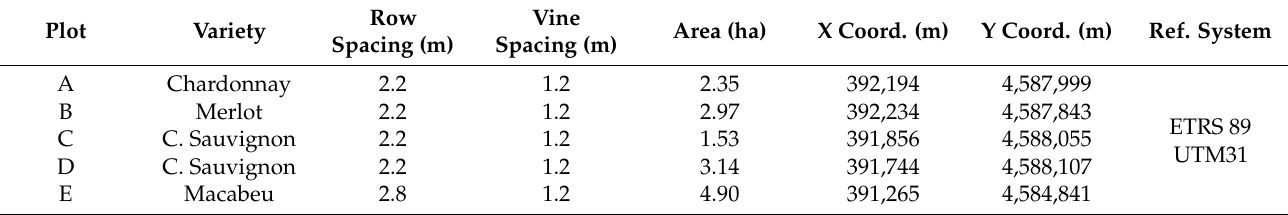
Table 1. Main characteristics of selected vineyard